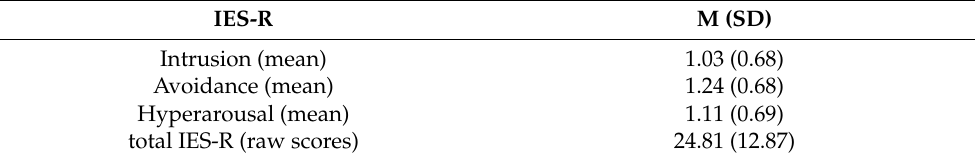
Table 2. Scores in the Impact of Event Scale: Revised (IES-R; N = 492; total